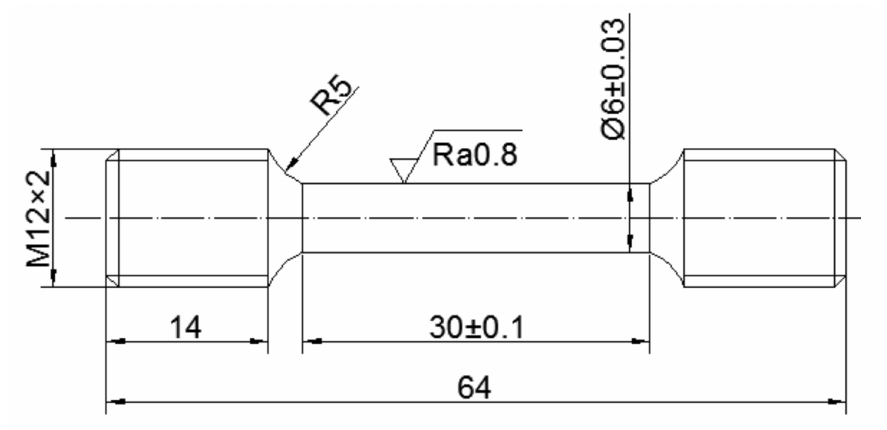
Figure 1. Geometry dimension of uniaxial tensile samples (unit: mm). Table 1. Annealing treatments after hot-upsetting (WC represents water cooling while FC indicates the furnace cooling to 620 ◦ C at 50 ◦ C/h).